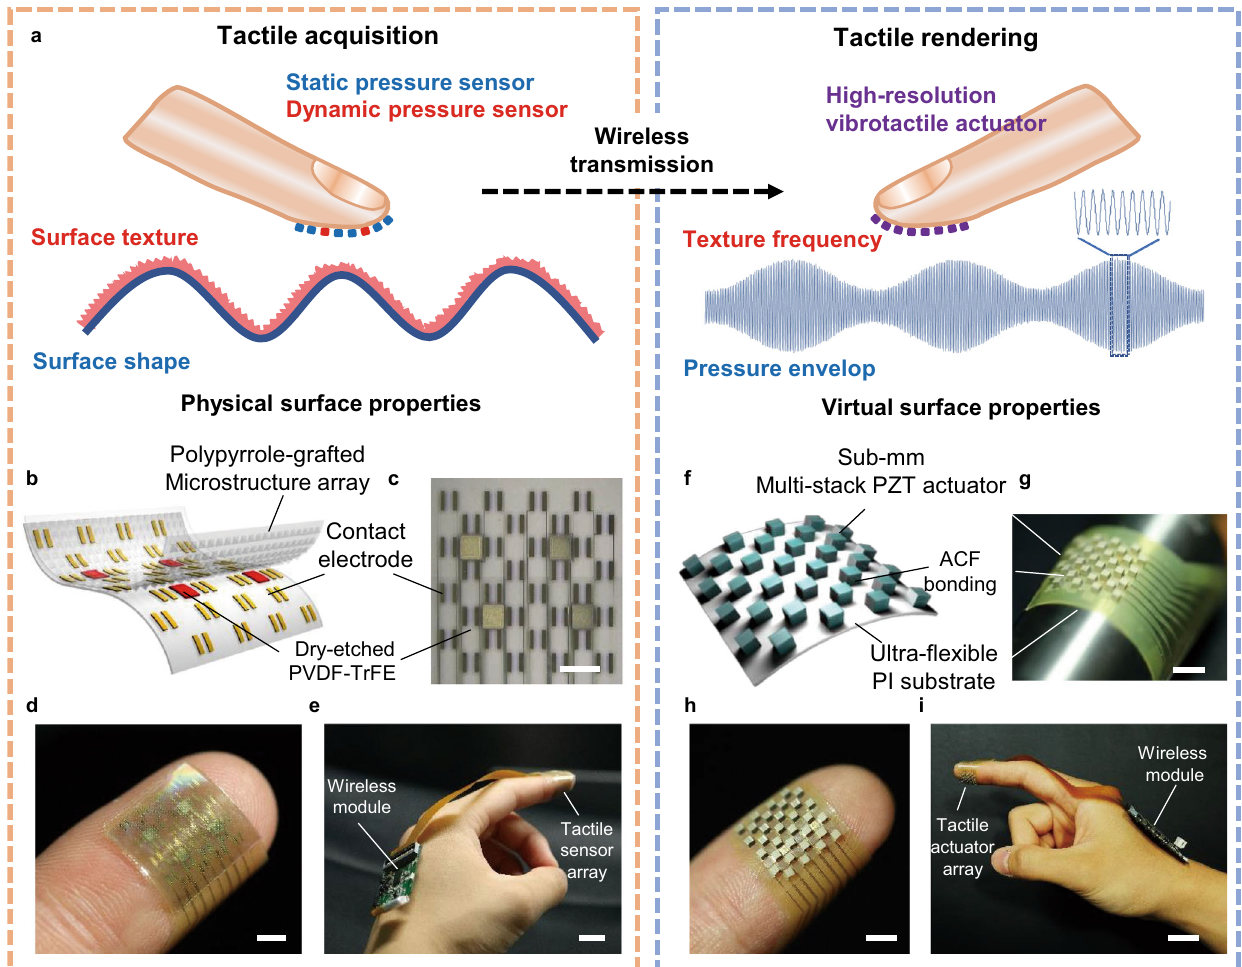
Fig. 1 Ultra- fl exible bimodal (UFB) tactile sensor and sub-mm tactile actuator array for telehaptic system. a Schematic of telehaptic system composed of tactile acquisition (left) and rendering (right). Physical surface properties including texture and shape are recorded by on-skin tactile sensor array and reproduced by tactile actuator array. b 3D schematic of ultra- fl exible bimodal (UFB) tactile sensor array. c Optical microscopy image of the UFB tactile sensor array, scale bar is 2 mm. d Image of the UFB tactile sensor laminated on the fi ngertip, scale bar is 2 mm. e UFB tactile sensor with a wireless system attached to the hand for tactile acquisition, scale bar is 2 cm. f 3D schematic of fl exible sub-mm tactile actuator array. g Image of the ultra- fl exible tactile actuator array, scale bar is 2 mm. h an ultra- fl exible sub-mm tactile actuator array laminated on the fi ngertip, scale bar is 5 mm. i tactile actuator array with a wireless system attached to the hand for tactile rendering, scale bar is 2